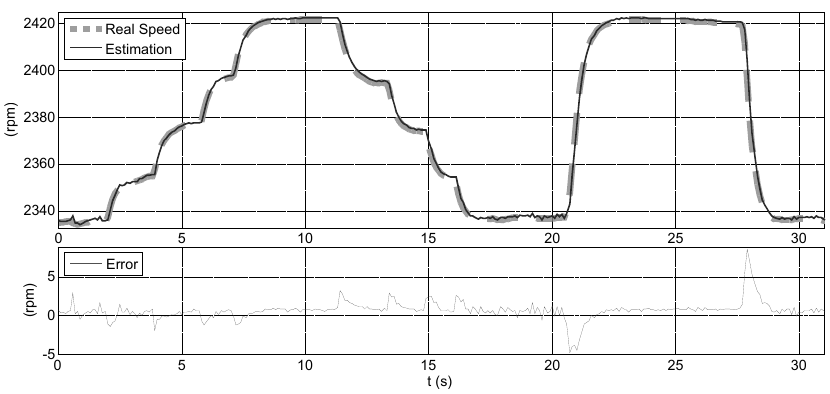
Figure 10. Actual and estimated speed for fast changes in speed.